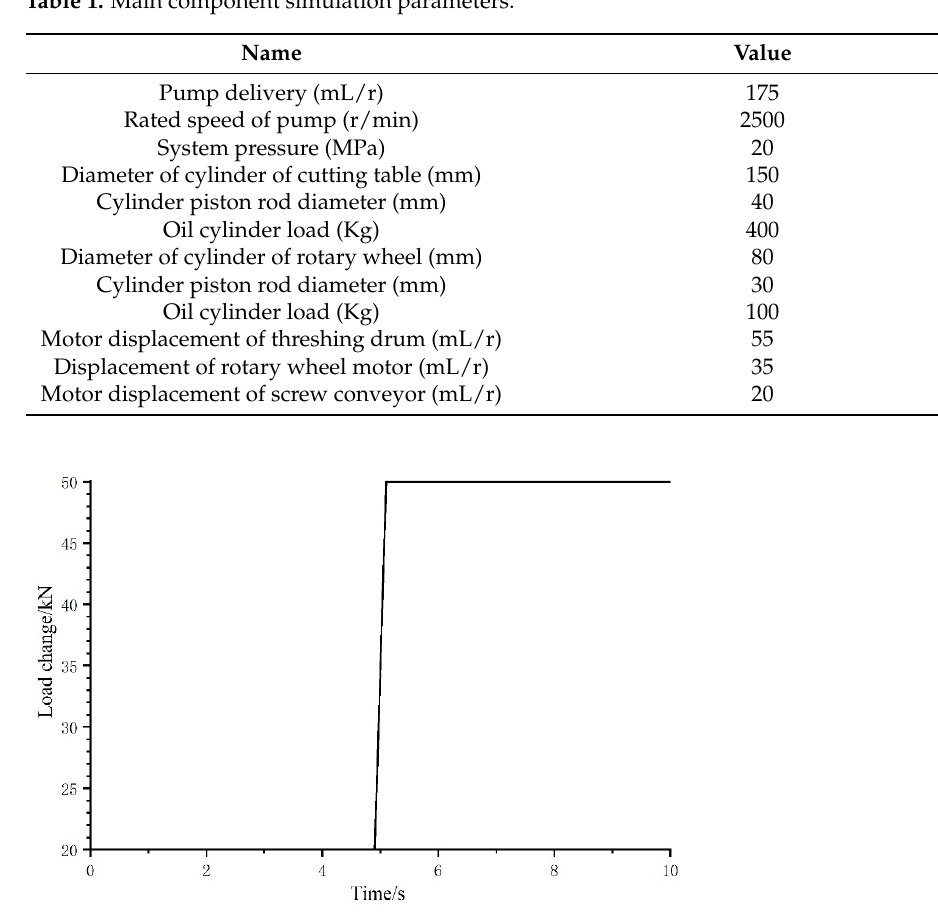
Figure 2. Load analog signal.